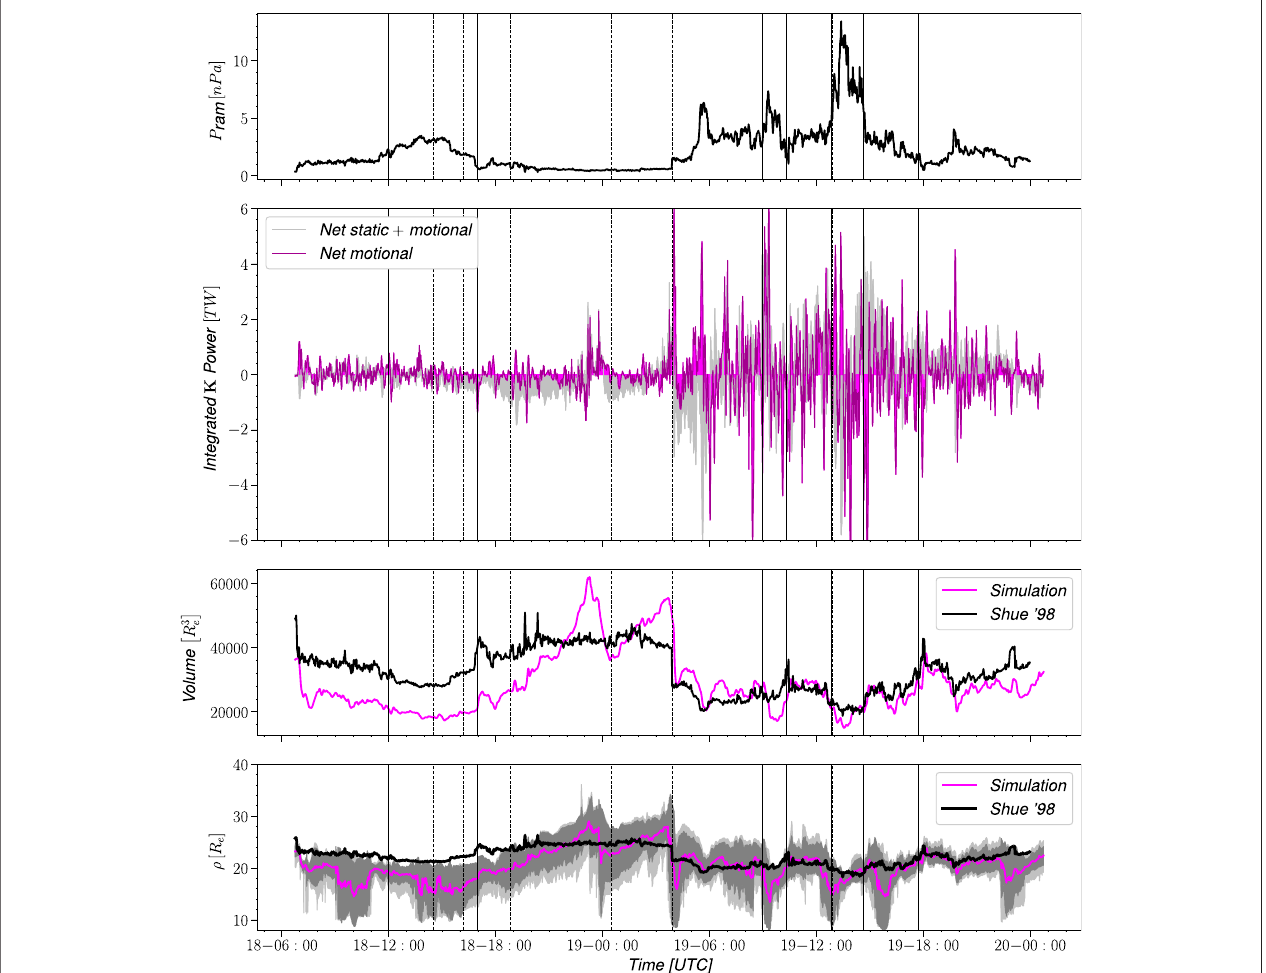
FIGURE 10 | From top to bottom: Solar wind ram pressure; Integrated net power transfer due to surface motion effects only (magenta) compared with static and motion effects (grey);Magnetosphere volume integrated from simulation (magenta) compared withShue 1998model (black); Radial distance ρ (cid:2) X (cid:2) − 10 R e for the magnetopause from simulation (magenta) with dark and light bars indicating ± 1.5 standard deviations and max/min respectively, compared with Shue